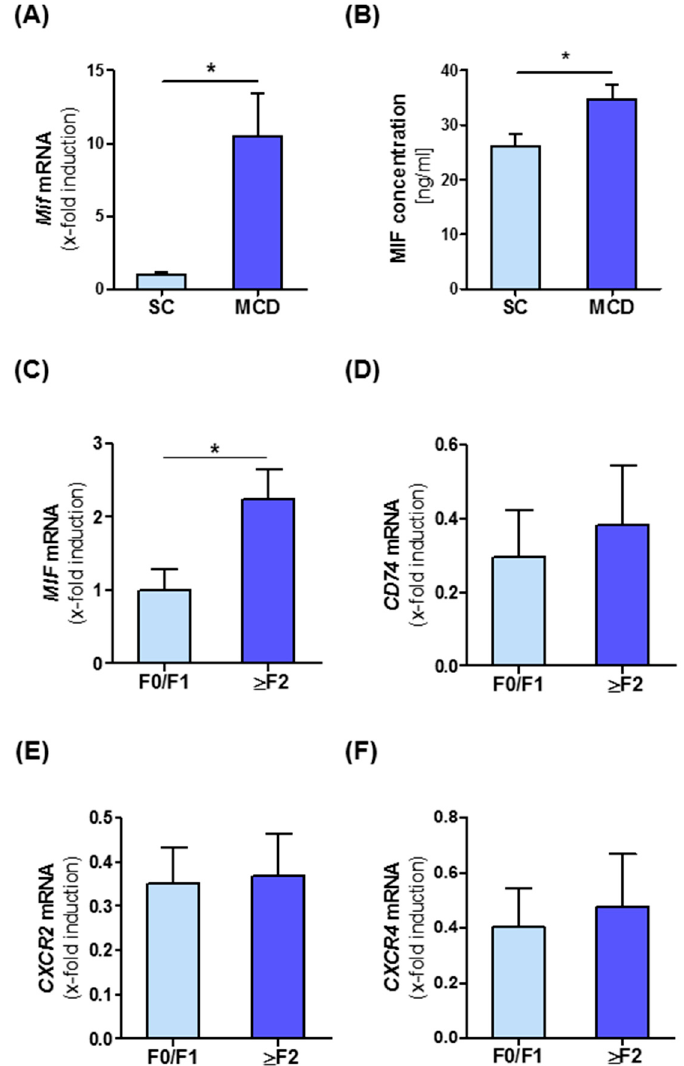
Figure 1. Intrahepatic migration inhibitory factor (MIF) expression is associated with progression of NASH in mice and human. ( A ) Expression of Mif mRNA in total liver tissue of wild-type (WT) mice which were fed with the methionine- and choline-deficient diet (MCD) diet for 8 weeks compared to standard chow-fed mice was measured by qRT-PCR ( n = 6 per group). ( B ) Expression of MIF on protein levels was measured by ELISA between the two groups ( n = 6 per group). ( C – F ) Expression of MIF , CD74 , CXCR2 and CXCR4 mRNA in different fibrosis grades in patients. Asterisks indicate statistical significance: * p < 0.05.